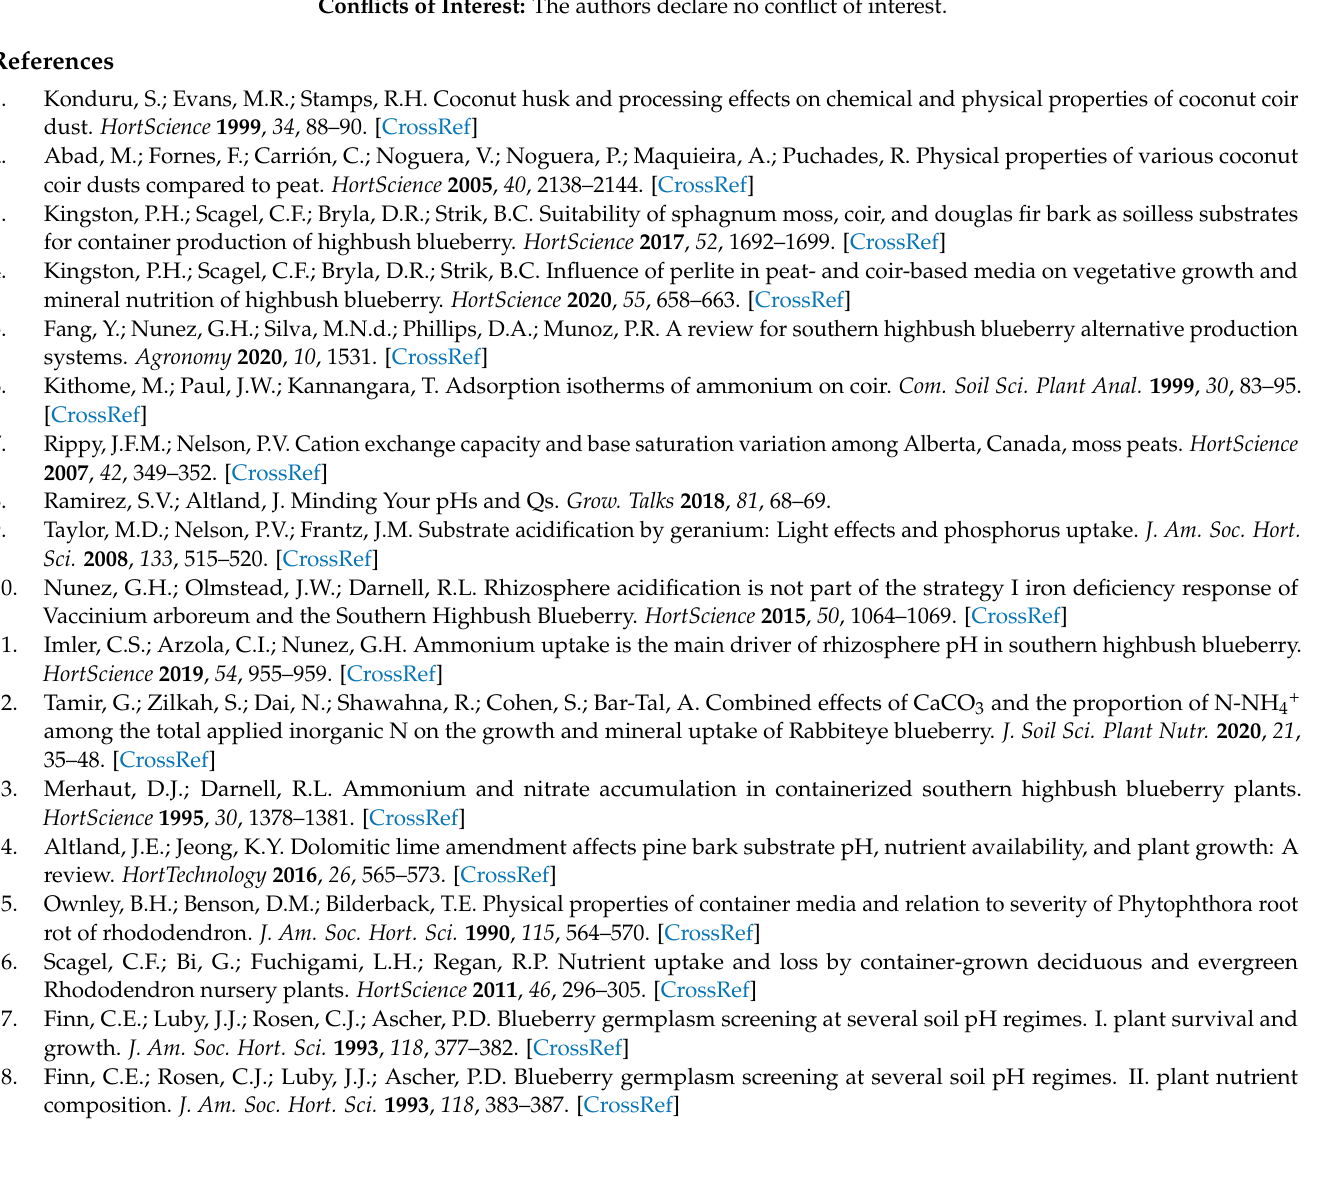
Table S2: Nutrient concentrations in leaves of ‘Emerald’ southern highbush